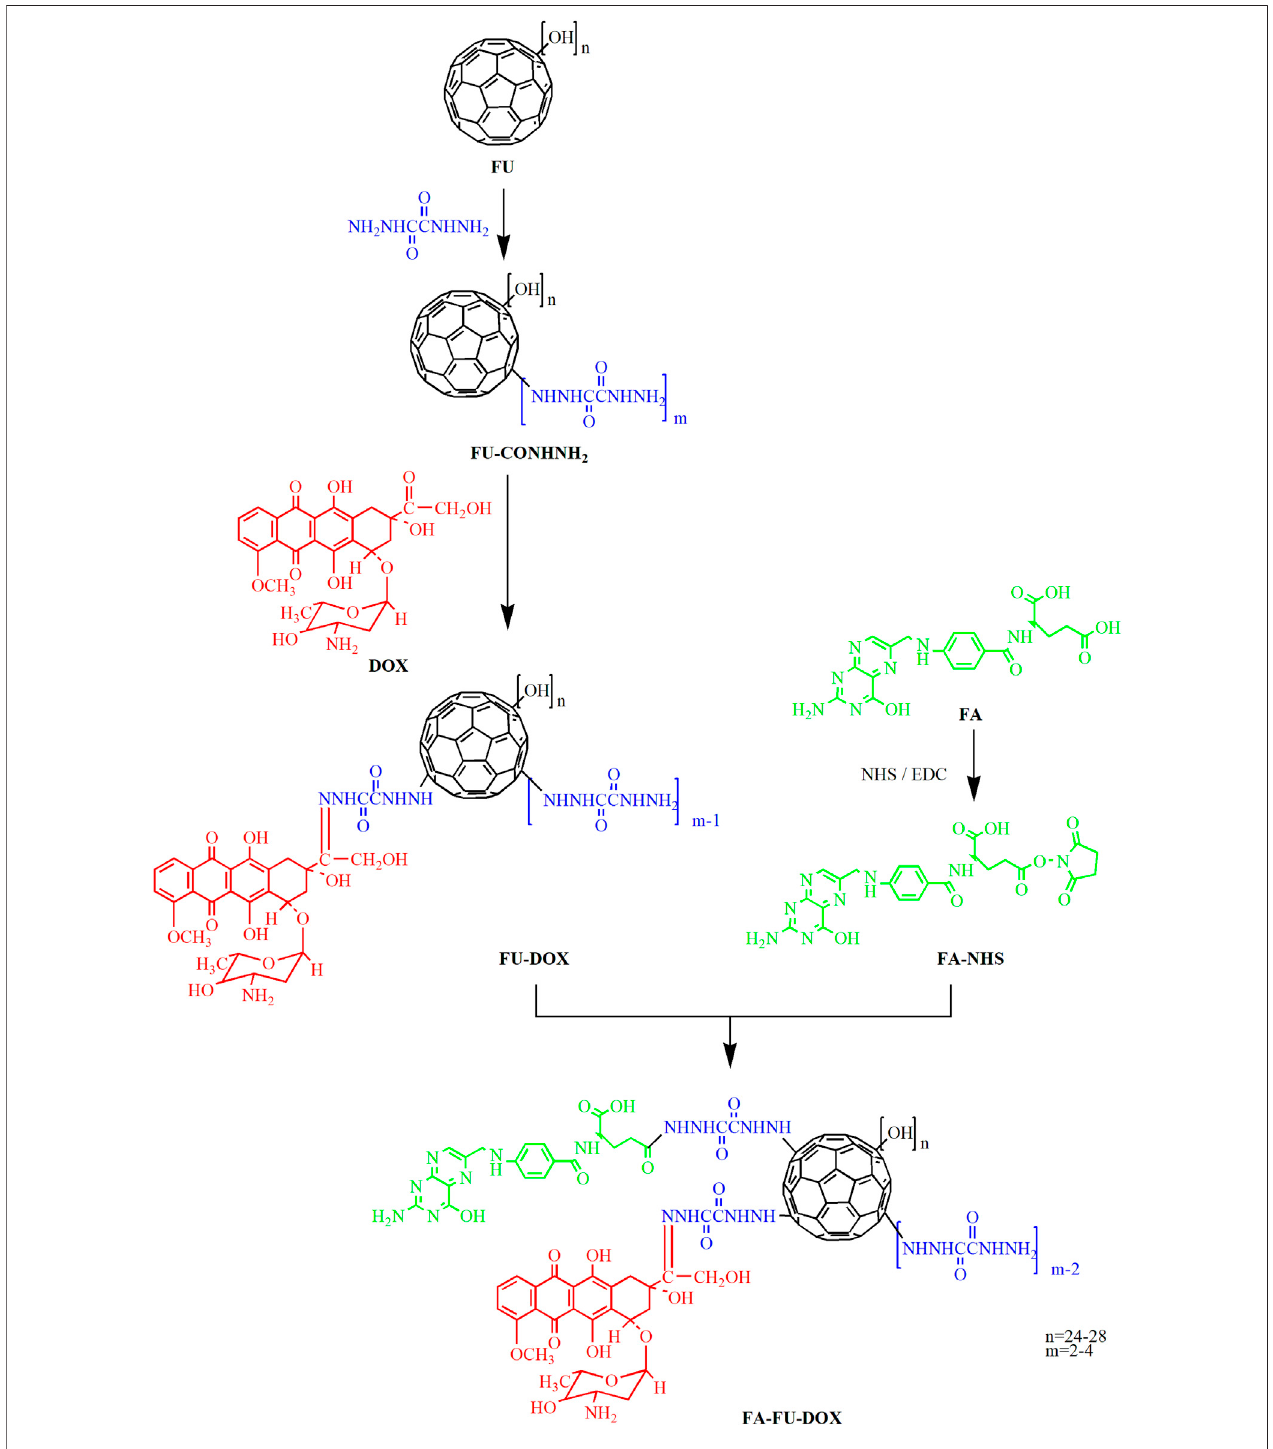
FIGURE 1 | Reaction route for the synthesis of FA-FU-DOX. DOX, and FA-FU-DOX. The infrared (IR) spectra were recorded on a Fourier-transform infrared (FTIR) spectrometer (Thermo Fisher Nicolet iS50). KBr tablets of DOX and DOX derivatives were used in the IR instrument. The IR spectra were acquired after 16